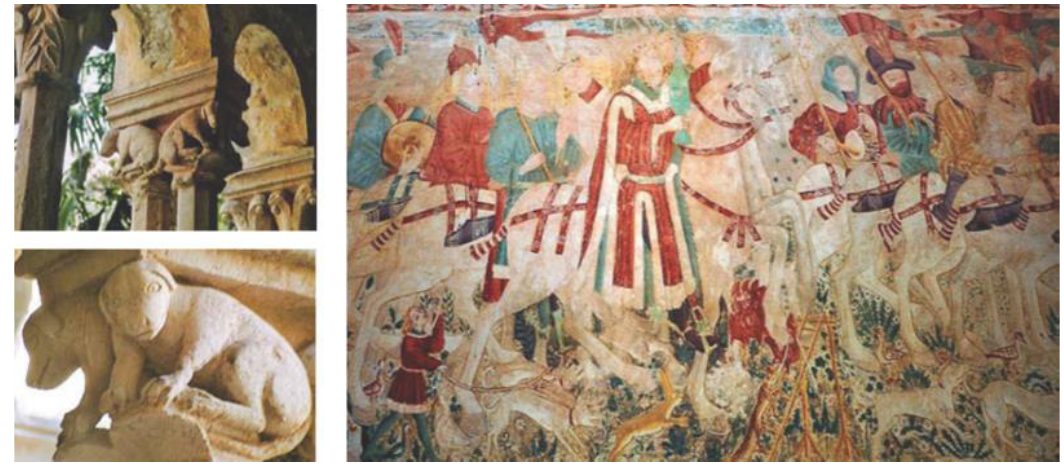
Figure 1. Historical traces of the breed’s origin [2] .